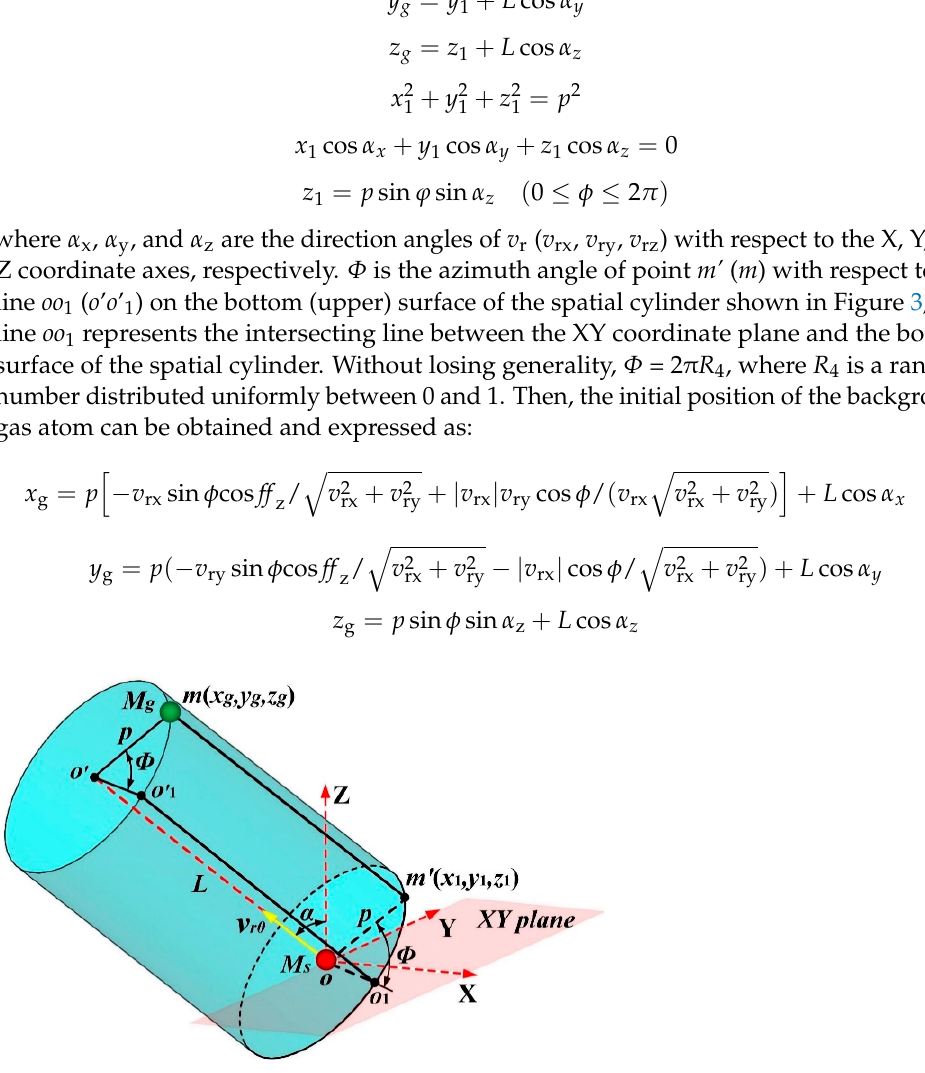
Figure 3. The relative position between the sputtered atom and background gas atom at the initial phase of elastic collision. Once the initial locations of two colliding atoms were determined, the velocity ( v g ) of the background gas atom can be chosen randomly from the Maxwellian distribution at 300 K, and the initial velocity ( v s ) of the sputtered atom can be selected from the Thompson distribution. Then, the elastic collision between the sputtered atom and the background gas atom was simulated by using the molecular dynamics code LAMMPS [29]. The size of the simulation domain was 100 × 100 × 100 Å 3 . Non-periodic and fixed boundary conditions were applied in all three directions in order to capture the entire collision process. The interaction between colliding atoms was described by the Ziegler-Biersack-Littmark (ZBL) potential [27] with a cut-off distance of 6.2 Å [30]. At the beginning of the simulation, the sputtered atom was placed at the geometric center of the simulation box (coordinate origin), while the background gas atom was put on the coordinates calculated according to Equations (20)–(22). The standard Velocity-Verlet algorithm was used for integrating Newton’s equation of motion. The time step was set to 0.1 fs [18]. The MD simulation